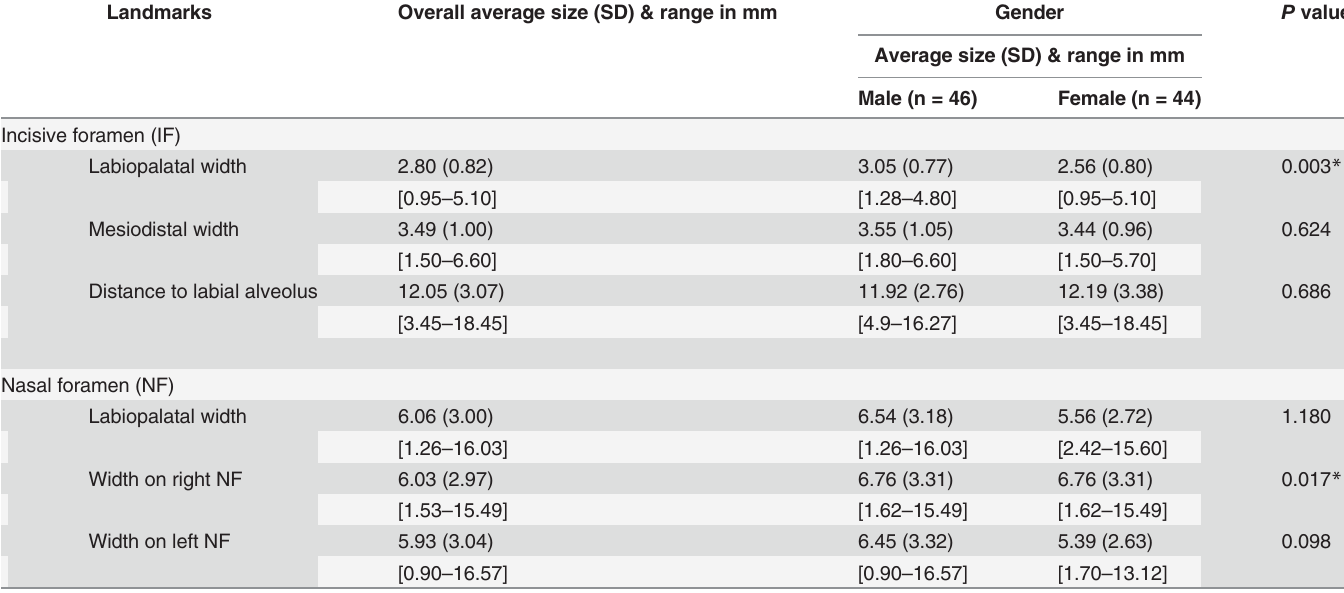
Table 1. The mean dimensional measurement of the incisive and nasal foramina.